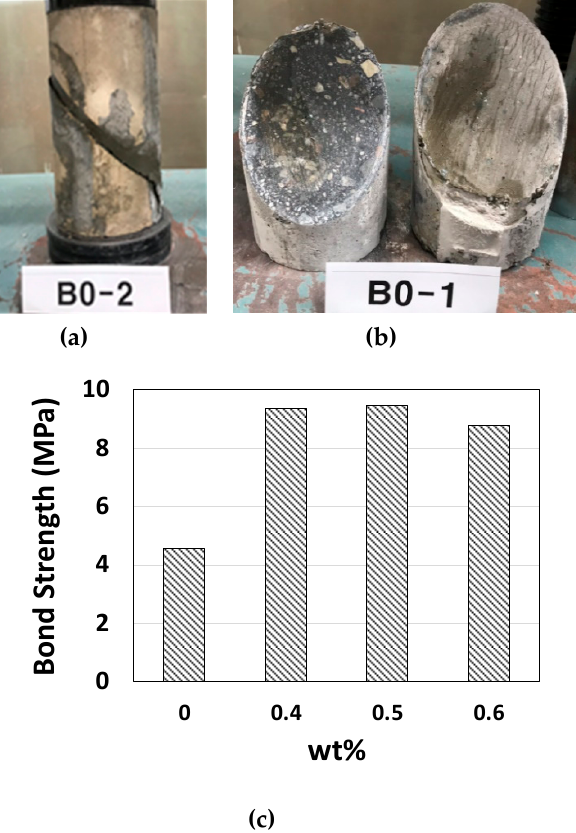
Figure 6. ( a ) Bond strength of nine concrete specimens (100 × 200 mm, pitch-based carbon fiber content of 0–0.6 wt %) thin slanted gap of 10 mm, ( b ) photograph of the specimen subjected to bond strength testing, and ( c ) bond strength by mixing ratio.